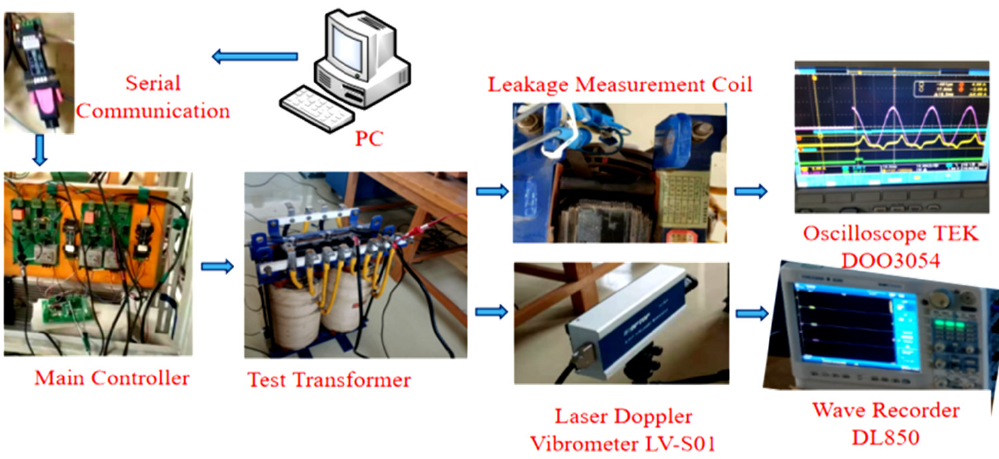
Figure 20. Test measurement site.